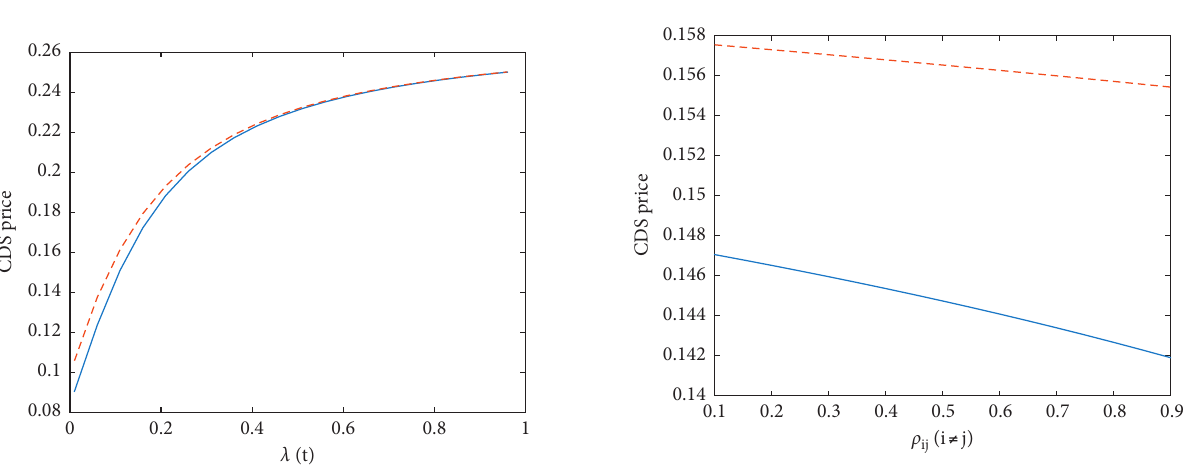
Figure 4: The CDS prices under different correlations.